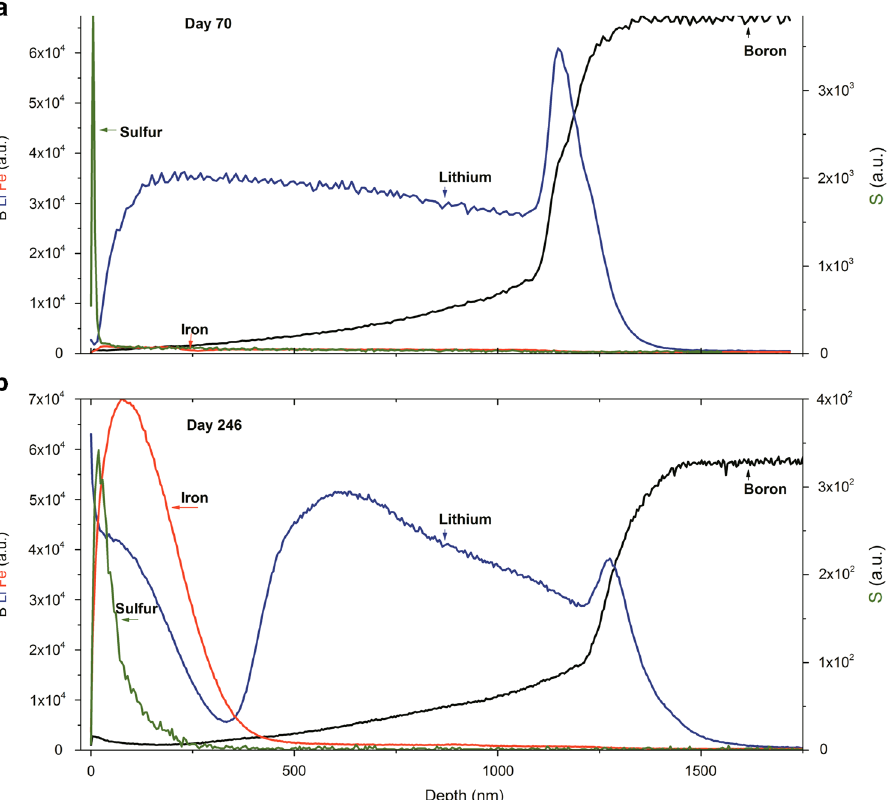
Fig. 10 TOF-SIMS elemental pro fi les of polished surface of monoliths sampled at ( a ) day 70 and ( b ) day 246, after tracing experiment with lithium and methylene blue (denoted by sulfur). Signi fi cant changes are seen in the fi rst 250 nm of the day 246